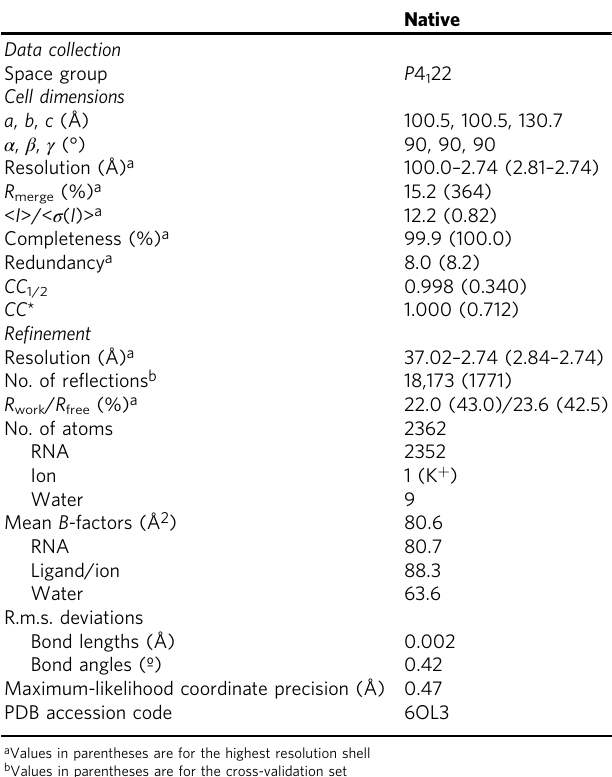
Table 1 Summary of crystallographic statistics of a native